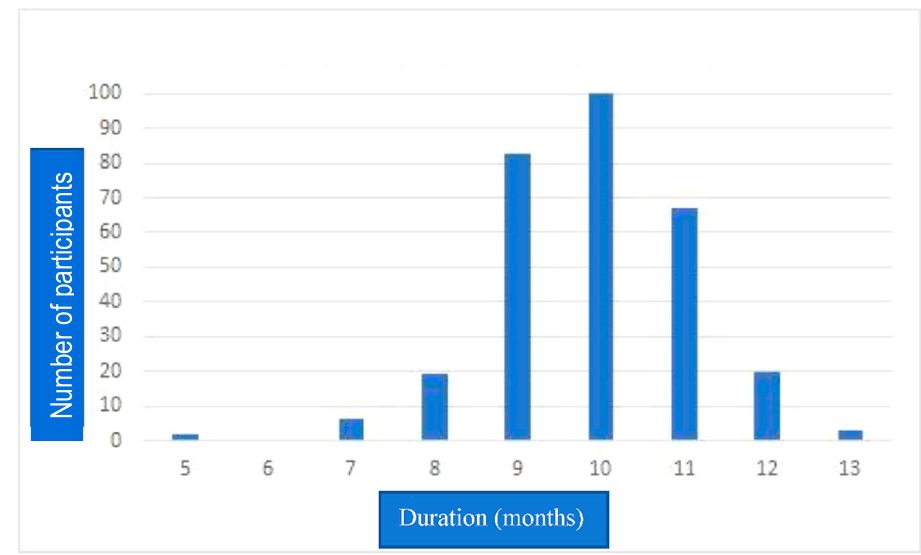
Figure 2. Interval between interview and booster vaccination. This figure shows variation in the time interval between booster vaccination and participants’ interview. The researchers set 5 months as the interval of outcome observation after booster vaccination for equivalence and to avoid bias. Table 2. Confirmed COVID-19 cases within 5 months of booster vaccination.